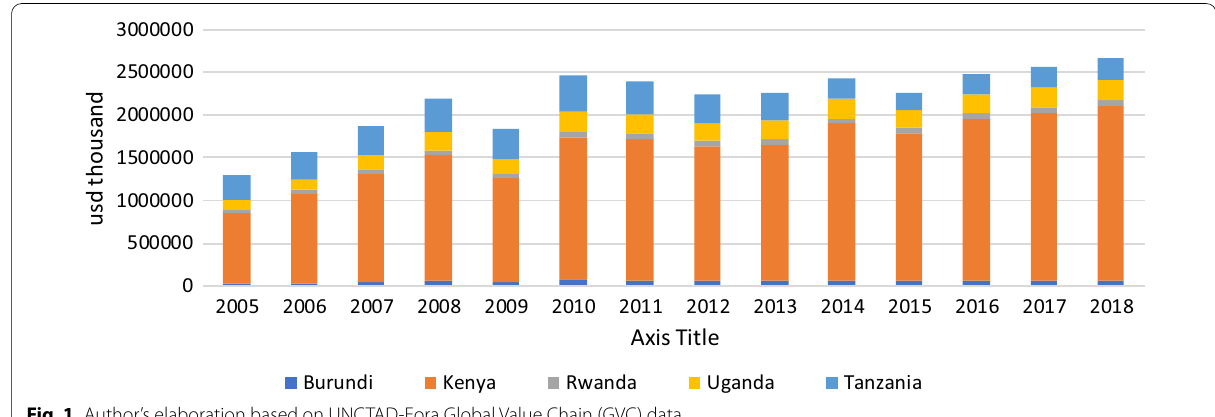
Fig. 1 Author’s elaboration based on UNCTAD-Eora Global Value Chain (GVC)